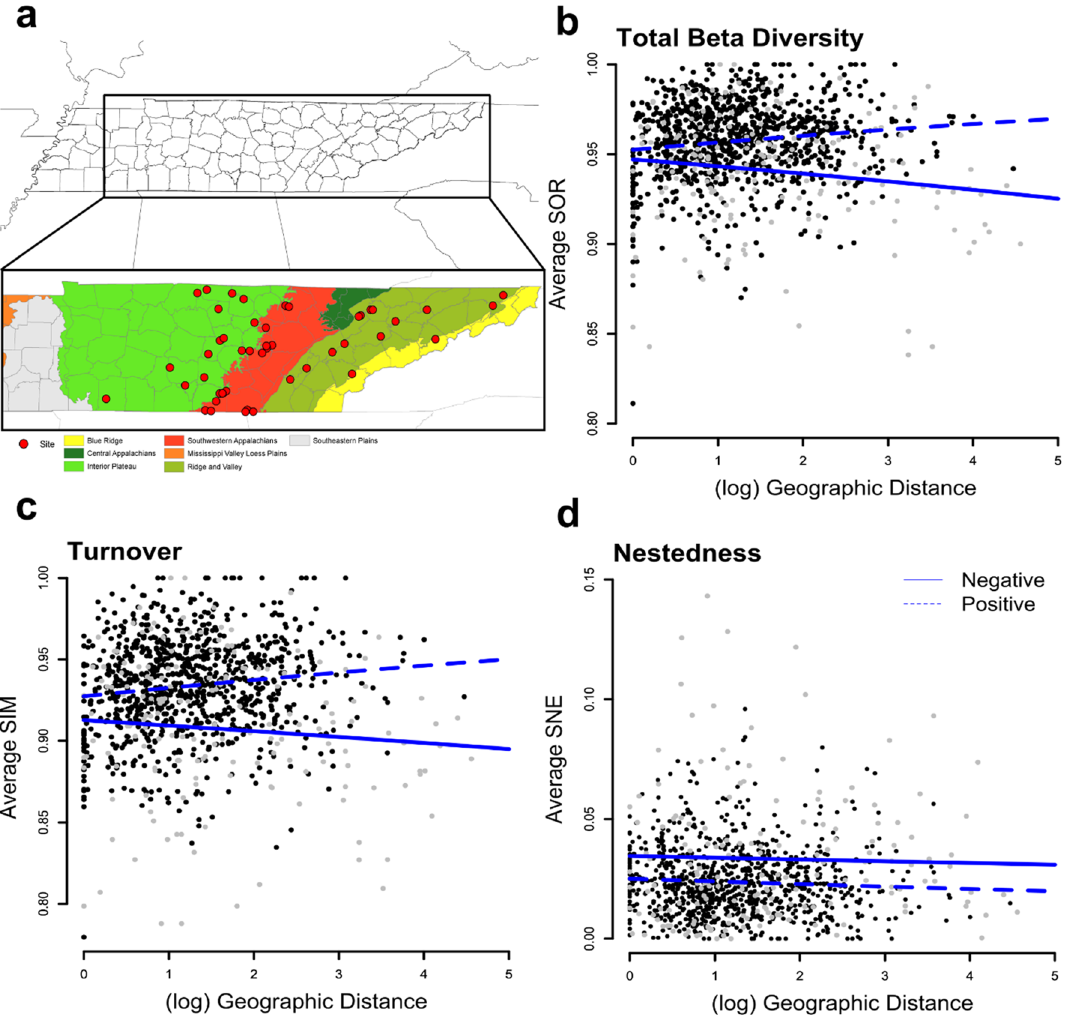
Figure 2. ( a ) Map of the study system, red dots indicate sample sites. Samples were collected across three Tennessee ecoregions (Interior Plateau in light green, South West Appalachians in red, and Ridge and Valley in olive green). Map produced using ArcGis 10.7.1. (https:// deskt op. arcgis. com/ en/ arcmap/) Copyright 1995–2018 Esri. All rights reserved. Published in the United States of America. Distance-decay relationships, comparing geographic distances between sites and ( b ) total beta diversity, ( c ) turnover, ( d ) nestedness, for P. destructans positive (dashed line and black dots) and P. destructans negative (solid line and grey dots) bats averaged by site. There is no significant relationship between geographic distance and community dissimilarity (GLM; SOR: z = 0.79, p > 0.05; SIM: z = 0.86, p > 0.05; SNE: z = 0.96, p > 0.05) or decay rates between disease states ( p > 0.05) for any metric (ANOVA; SOR: p > 0.05, SIM: p > 0.05, SNE: p > 0.05). Graphs were produced using the ggplot2 package (version 3.3.2) in R 25 different between P. destructans positive and negative bats for total beta diversity (betadisper; SOR: F 1, 247 = 5.89, p ≤ 0.05, Supplemental File 1G). Interestingly, analyses of multivariate dispersion indicated that there was a sig- nificant interactive effect between P. destructans status and ecoregion for both total beta diversity and turnover (betadisper; SOR: F 5,243 = 15.232, p ≤ 0.05; SIM: F 5,243 = 8.646, p ≤ 0.05, Supplemental File 1G; Figs. 5a,b, 6). Post-hoc analysis of the interaction term for total beta diversity showed that dispersion was not different across ecoregions for P. destructans positive bats but varied for P. destructans negative bats (Fig. 5a). In general, disper- sion was large in P. destructans positive bats, with negative bats within the Interior Plateau having significantly less dispersion (Fig. 5a), largely driven by a difference in the turnover component (Fig. 5b). PERMANOVA revealed that average community composition (multivariate centroids) differed between P. destructans status and ecoregion when analyzing both total dissimilarities and the turnover component, but not nestedness, and that these effects were independent of each other (Fig. 6, Table 2).